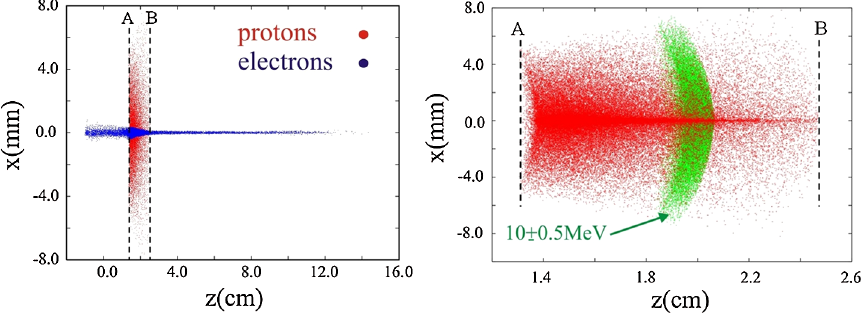
FIG. 12. Proton (red) and electron (blue) distribution in the z - x plane after 460 ps. Electrons are accelerated axially by their own potential. The detail AB containing the whole proton distribution is shown on the right. The green marked area corresponds to the protons with 10 MeV (cid:2) 0 : 5 MeV .